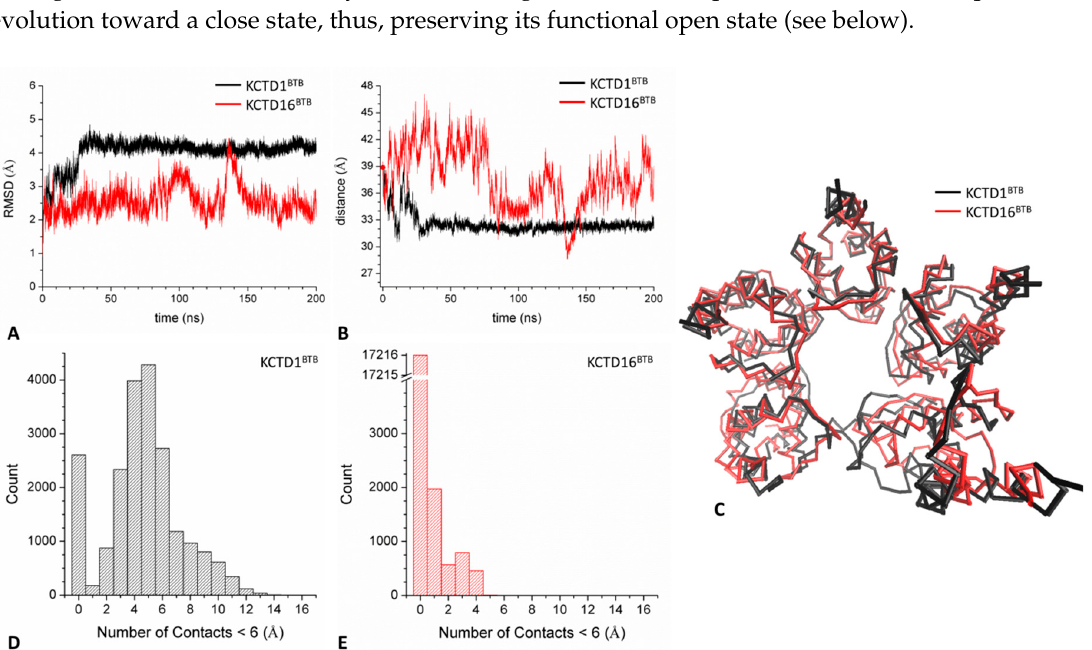
Figure 5. C α -based RMSD values of trajectory structures against the starting model obtained in the MD simulations performed on KCTD1 BTB and KCTD16 BTB open pentamers ( A ). Distance between the centers of mass of the two external domains that delimitate the gap in KCTD1 BTB and KCTD16 BTB open pentamers ( B ). The red dot indicates the common starting value (~39 Å). Superimposition of the C α -trace of KCTD1 BTB and KCTD16 BTB average structures computed in the equilibrated region of trajectories (50–200 ns) ( C ). Distribution of the number of atoms of the two external domains that are within 6.0 Å in KCTD1 BTB ( D ) and KCTD16 BTB ( E ).